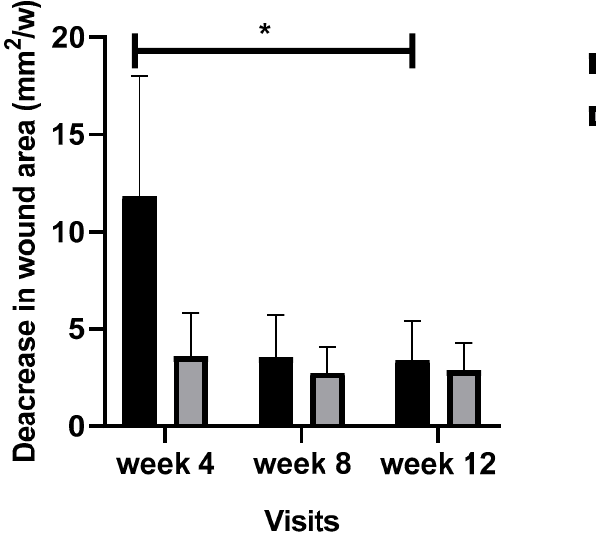
Figure 4. Comparison of the healing rate during the 12 weeks of the study period. Bars represent the means ± SEM. * Denotes a significant time by group interaction ( p ≤ 0.05).